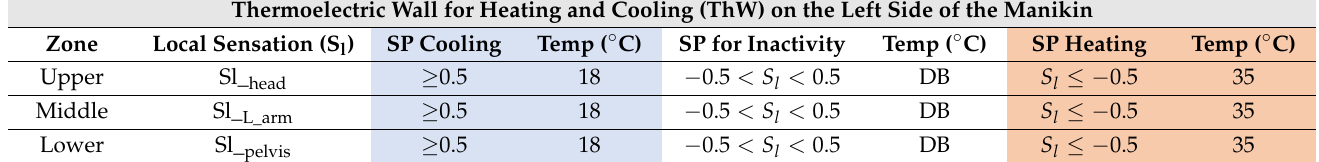
Table 1. Local sensation setpoints to control the surface temperatures of the three zones of the thermoelectric partition [52].